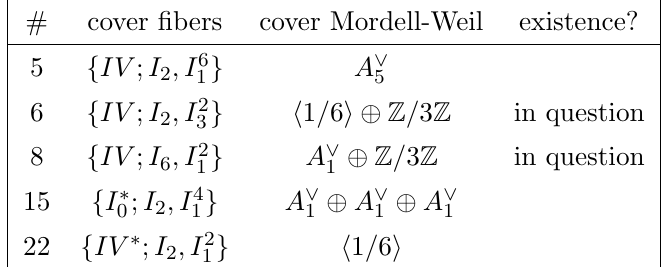
Table 6 . Covering rational elliptic surfaces for the 5 rank-1 false-gaugings. # is model number in table 1 of [3]. The third column yields the Mordell-Weil group of the covering surfaces (notation: g _ stands for the weight lattice of the simply-laced, simple Lie algebra g ; h 1 = 6 i stands for Z endowed with the quadratic form 1 x 2 ). In the last column we indicate the SCFT whose existence is put in 6 question in ref.